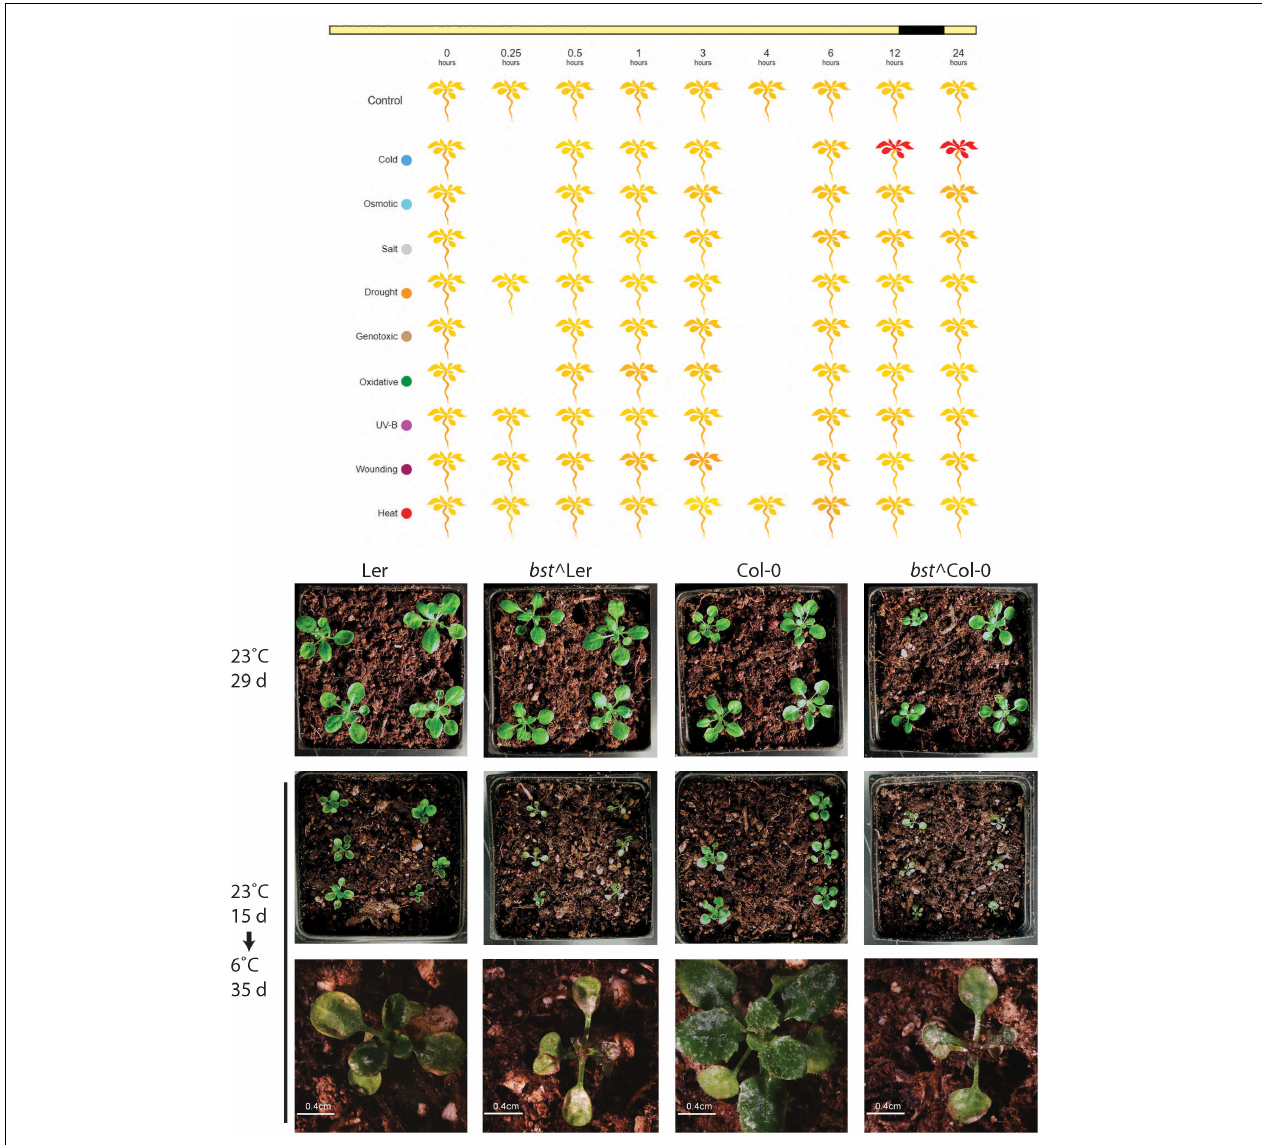
FIGURE 5 | bumpy stem responses to low temperatures. bst expression is induced by cold temperatures but not by other abiotic stresses. Yellow indicates low expression and red indicates high expression [data from Kilian et al. (2007), image generated using eplant at bar.utoronto.ca/eplant (Waese et al., 2017)]. Normal plants and bst plants in both Ler or Col-0 backgrounds were grown for 15 days at 23 ◦ C. Untreated plants were grown for an additional 14 days at 23 ◦ C while cold treated plants were transferred to 6 ◦ C and grown for an additional 35